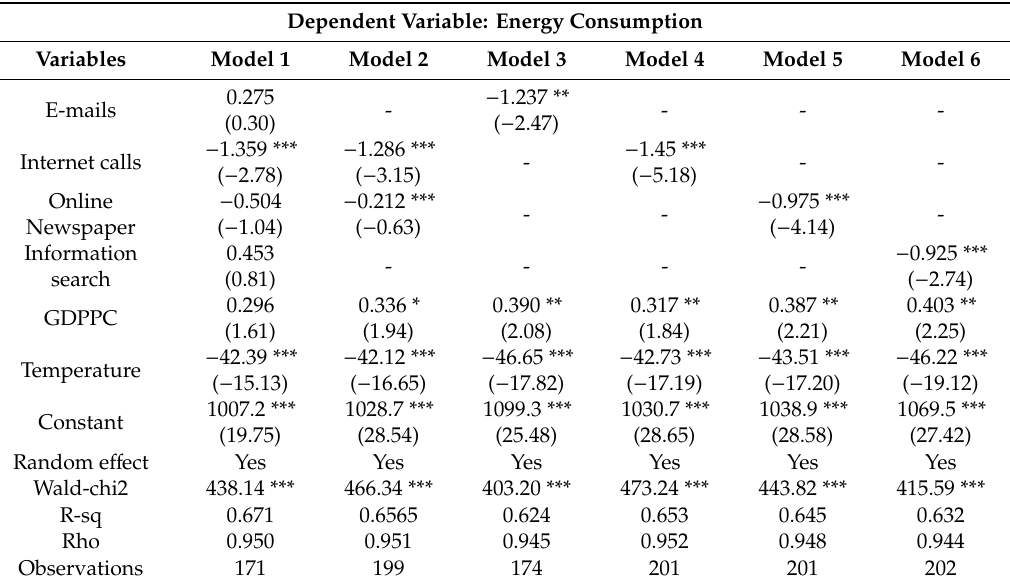
Table 6. Panel regression for the variables in group